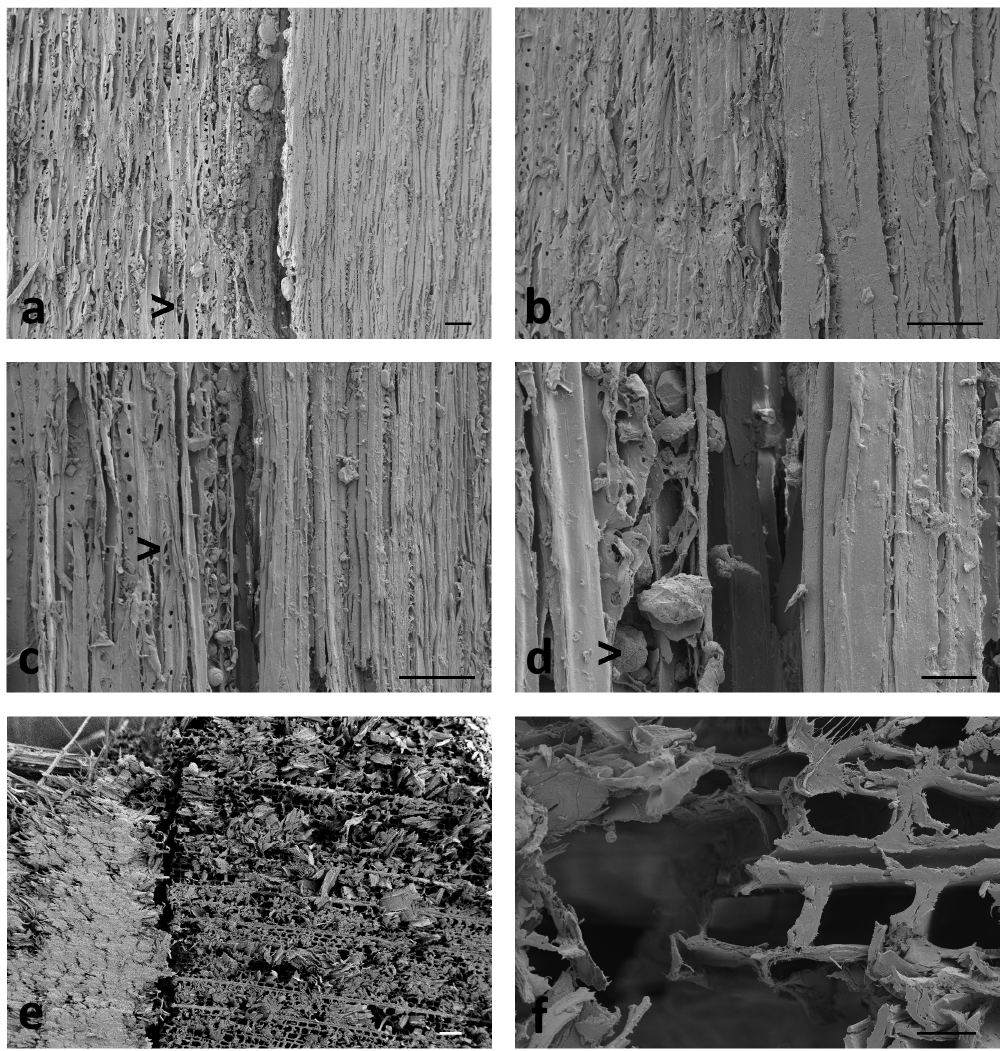
Figure 6. Scanning electron microscopy images of shelled growth rings in small samples from flat ACQ-treated Douglas fir, white spruce and western hemlock deckboards with growth rings oriented pith-side-up and exposed to the weather for 18 months in Vancouver, Canada: ( a ) Douglas fir sample showing separation of latewood (right) from earlywood. Note pit micro-checking in earlywood (arrowed bottom left); ( b ) white spruce sample showing separation of latewood (right) from earlywood; ( c ) western hemlock sample showing separation of latewood (right) from earlywood. Note pit micro-checking in earlywood (arrowed centre left); ( d ) western hemlock sample showing failure of earlywood cell wall (centre) where latewood separates from earlywood. Note mould in earlywood (arrowed bottom left); ( e ) a cross section through a shelled growth ring in western hemlock showing separation of latewood (left) from earlywood; and, ( f ) a cross section through a shelled growth ring in western hemlock showing failure of earlywood cell walls where latewood (left) separates from earlywood. Scale bars ( a – c , e ) = 100 µm; ( d , f ) = 20 µm.